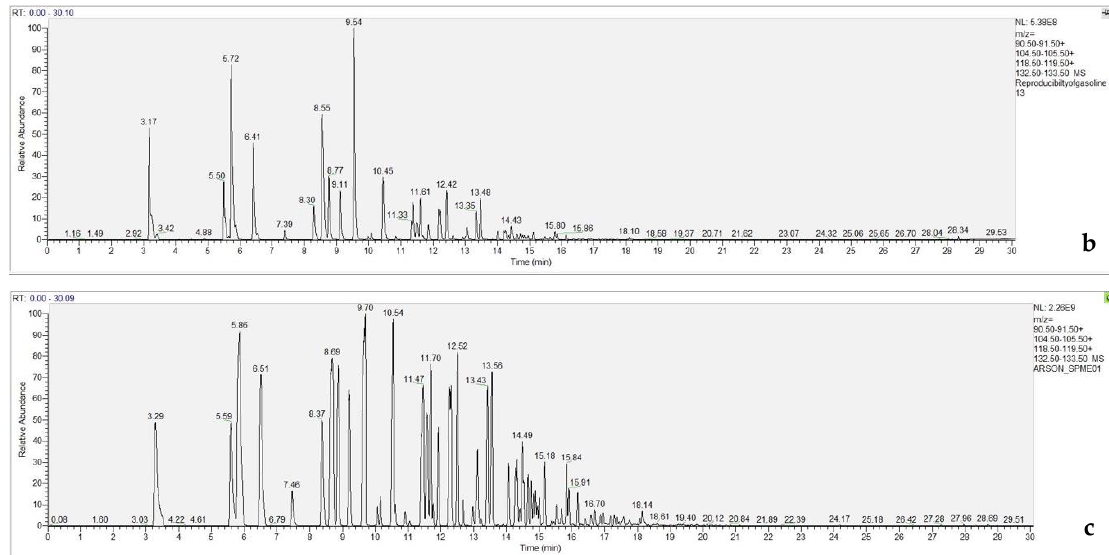
Figure 4. Extracted aromatic (alkylbenzenes) profiles of ( a ) carpet #1 burned without ILs; ( b ) carpet#1 burned with gasoline; and ( c ) neat gasoline.